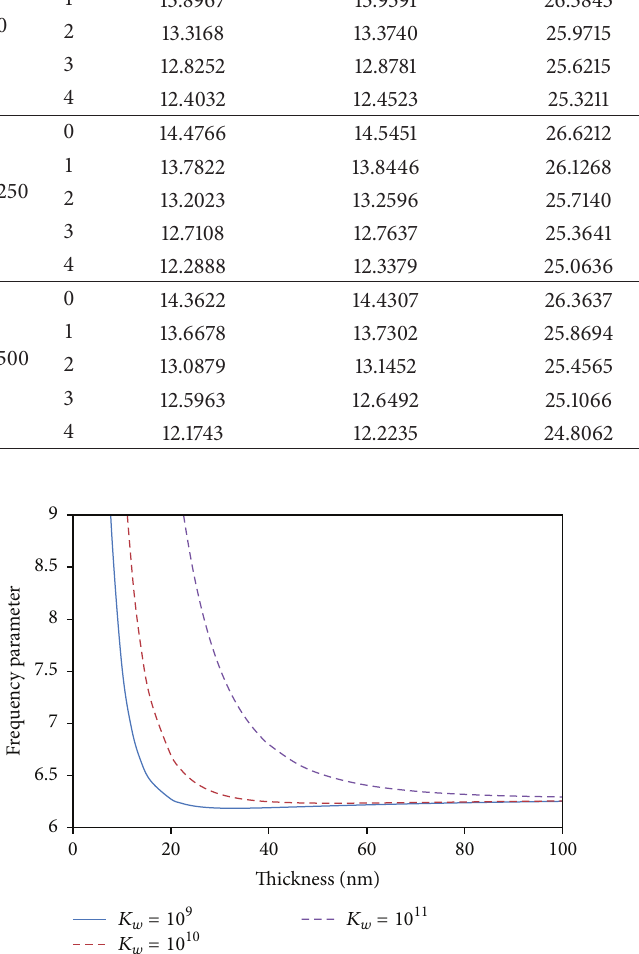
Figure 9: Dimensionless critical buckling load with respect to thickness ℎ for various Winkler elastic foundations (𝐾 𝑝 = 10 −6 , 𝑅 = 30 nm , Δ𝑇 = 100, 𝜇 = 1, 𝑏 = 50 nm , 𝜃 = 𝜋/2)